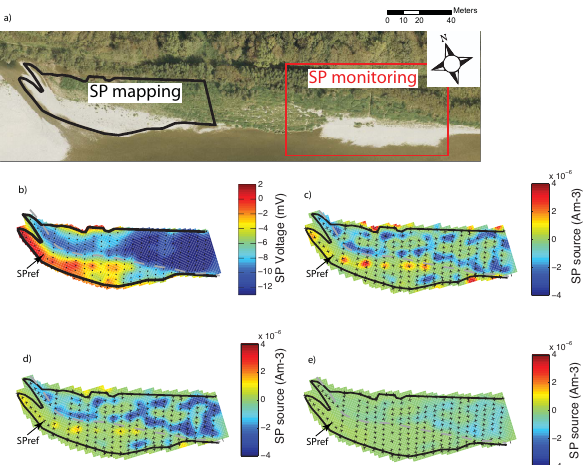
Fig. 2. (a) The gravel bar at Neunforn on which SP mapping and SP monitoring (see Fig. 3) was carried out. (b) The kriged SP map with measurement locations. (c–e) Source current distributions at 1.5–2m, 3.5–4m, and 5.5–6m depth obtained from inversion. The boundaries of the gravel bar are indicated with a black solid line, whereas the gray dashed line indicate the transition between the grassy areas and the barren gravel